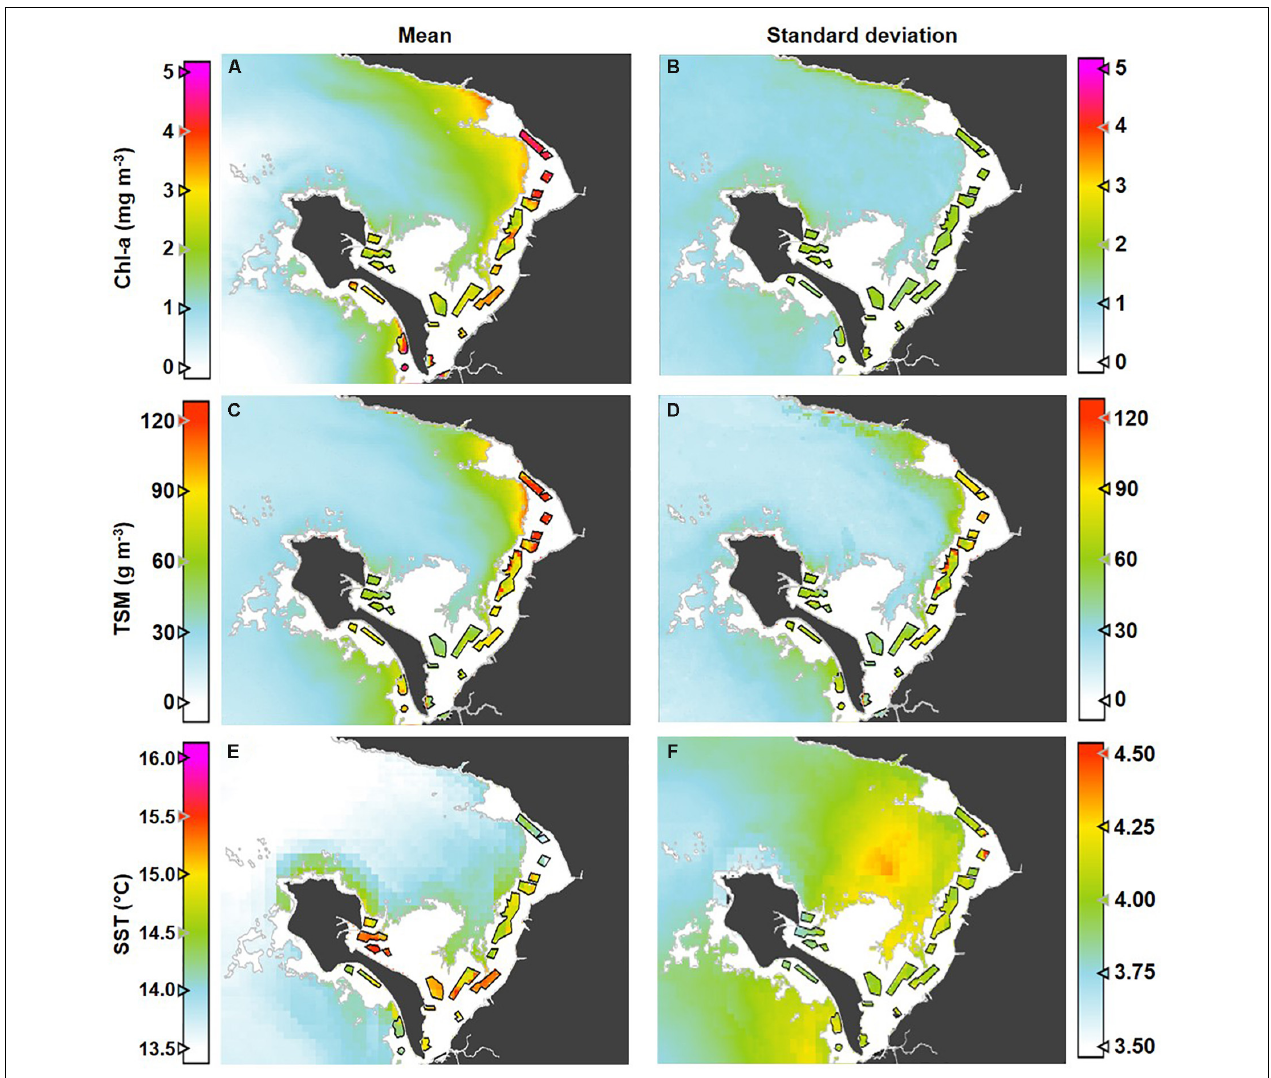
FIGURE 5 | Maps of interannual mean (left) and standard deviation (right) for input products across the full nine-year time series; (A,B) Chl-a, (C,D) TSM, and (E,F) SST. In the intertidal zone, the Chl-a, TSM, and SST mean and standard deviation are shown within the farming sites only (i.e., unmapped for the white area).